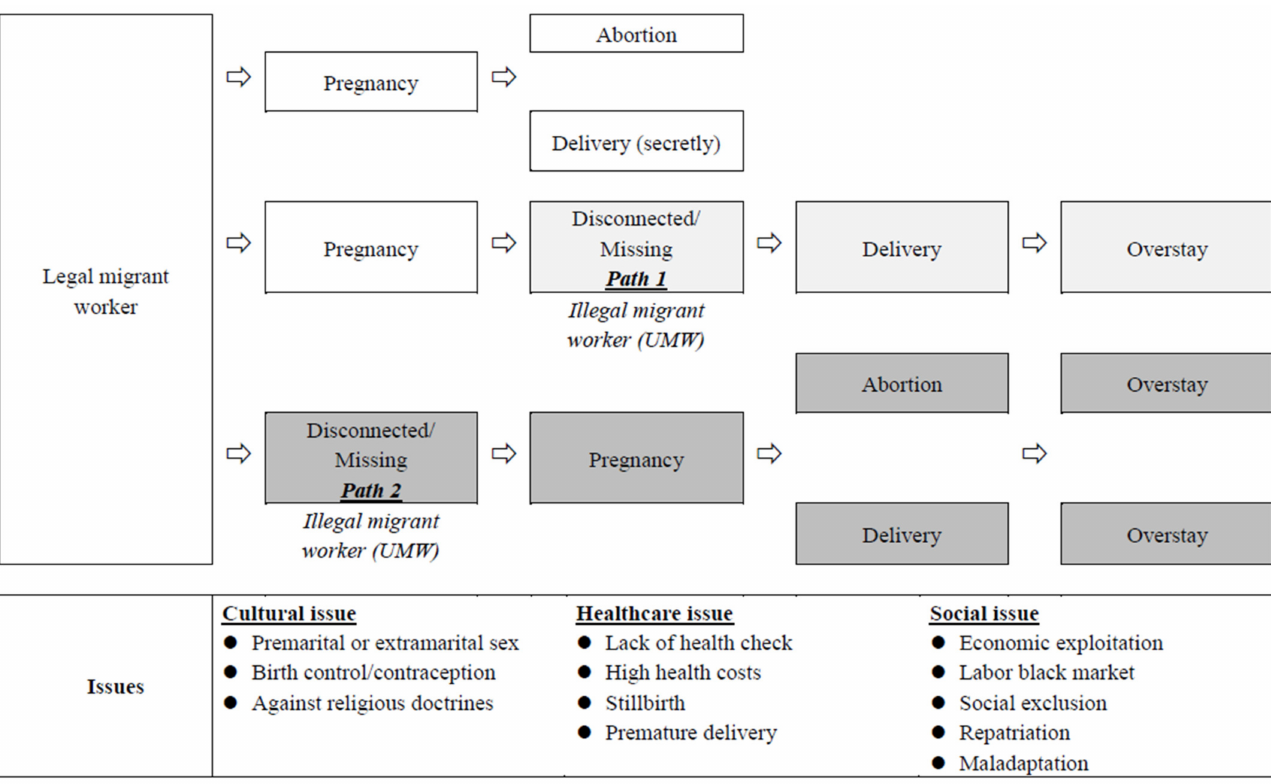
Figure 1. Paths of legal female migrant workers being pregnant and becoming unaccounted for migrant workers (UMWs) Various